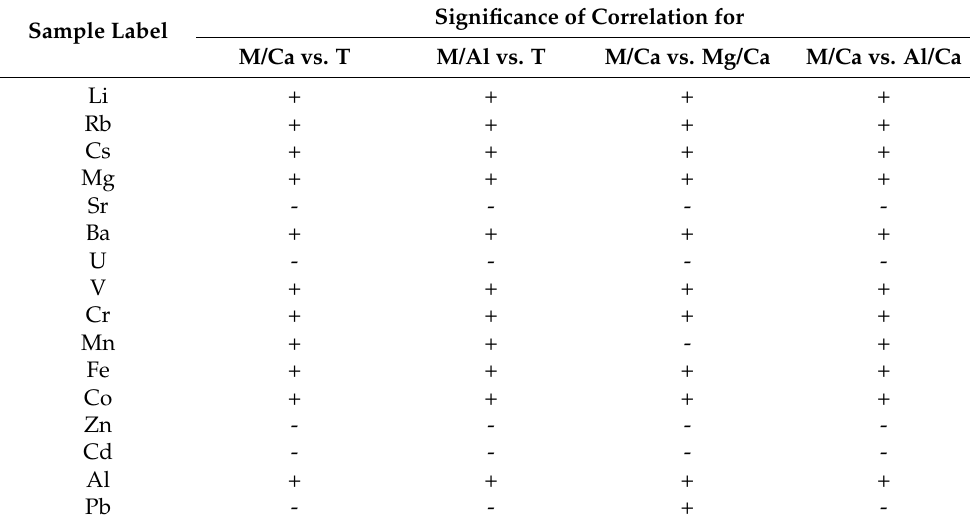
Table A3. Significance of correlations of M/Ca and M/Al (M element) vs. temperature (T), M/Ca vs. Mg/Ca and M/Ca vs. Al/Ca for the Korana River tufa layers (“+” significant positive correlation, “-” no correlation, p < 0.05).